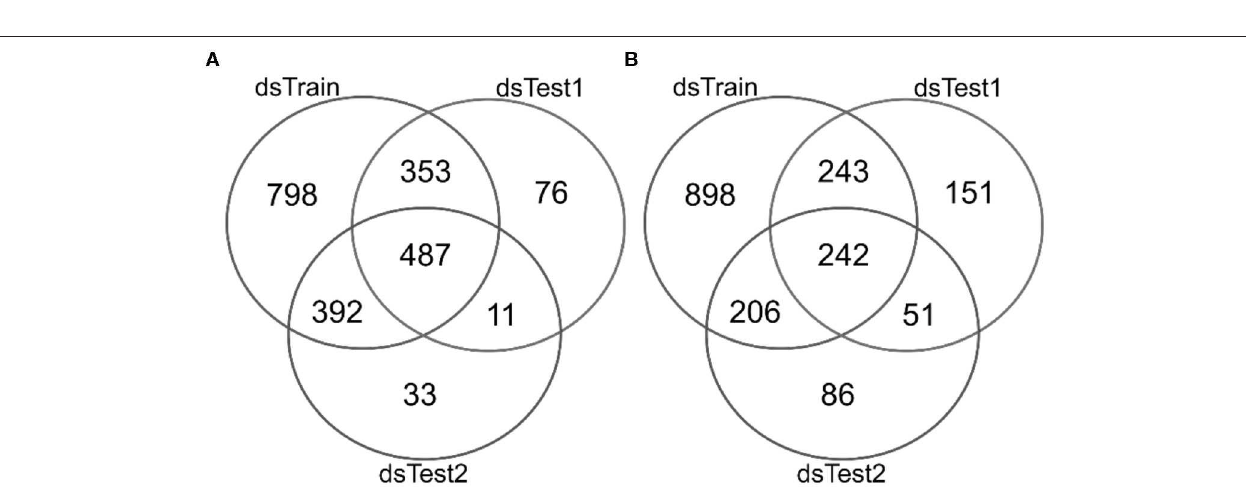
FIGURE 1 | Flowchart of this study. This study uses three datasets, i.e., Train, Test1, and Test2. The regression model of each mRNA feature is trained over the 70% randomly-chosen N samples in the dataset Train.